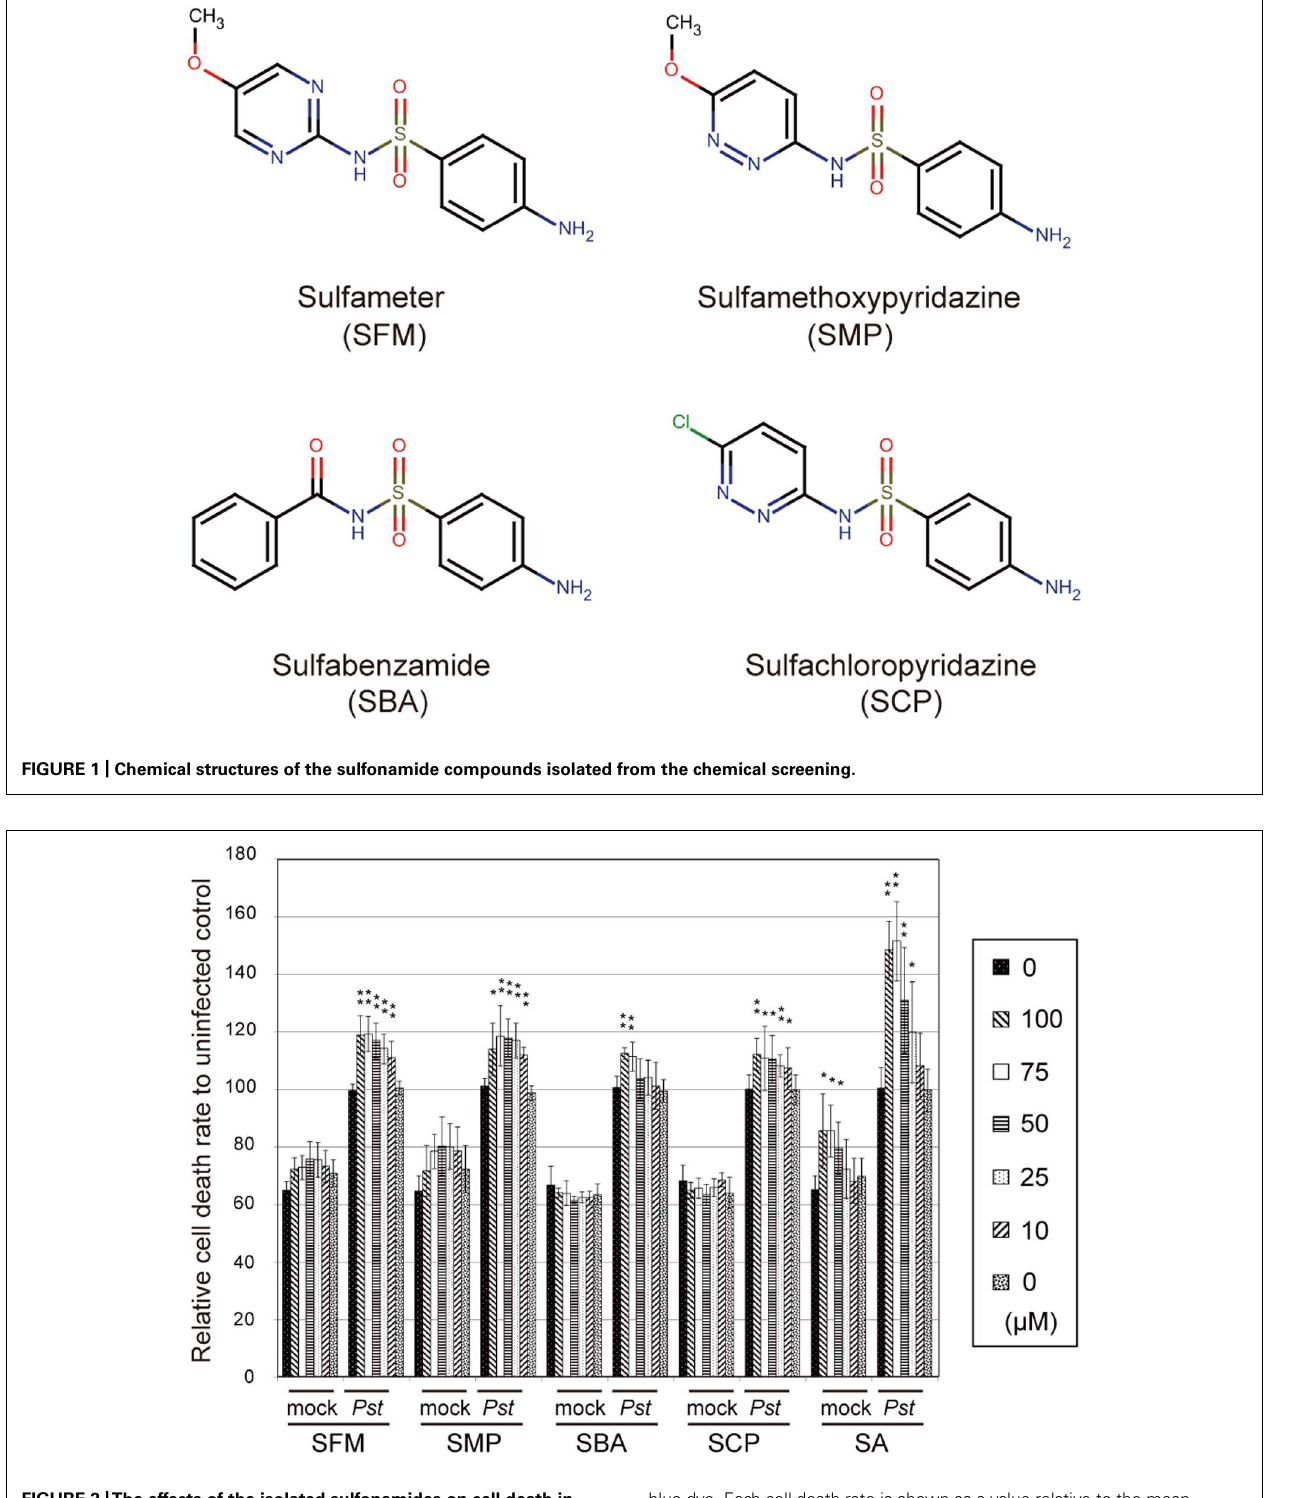
FIGURE 2 |The effects of the isolated sulfonamides on cell death in Arabidopsis suspension cultures upon challenge with pathogenic bacteria. The compounds were incubated with Arabidopsis suspension-cultured cells with or without the avirulent bacterial pathogen Pst-avrRpm1 , and the degree of cell death was measured using Evans